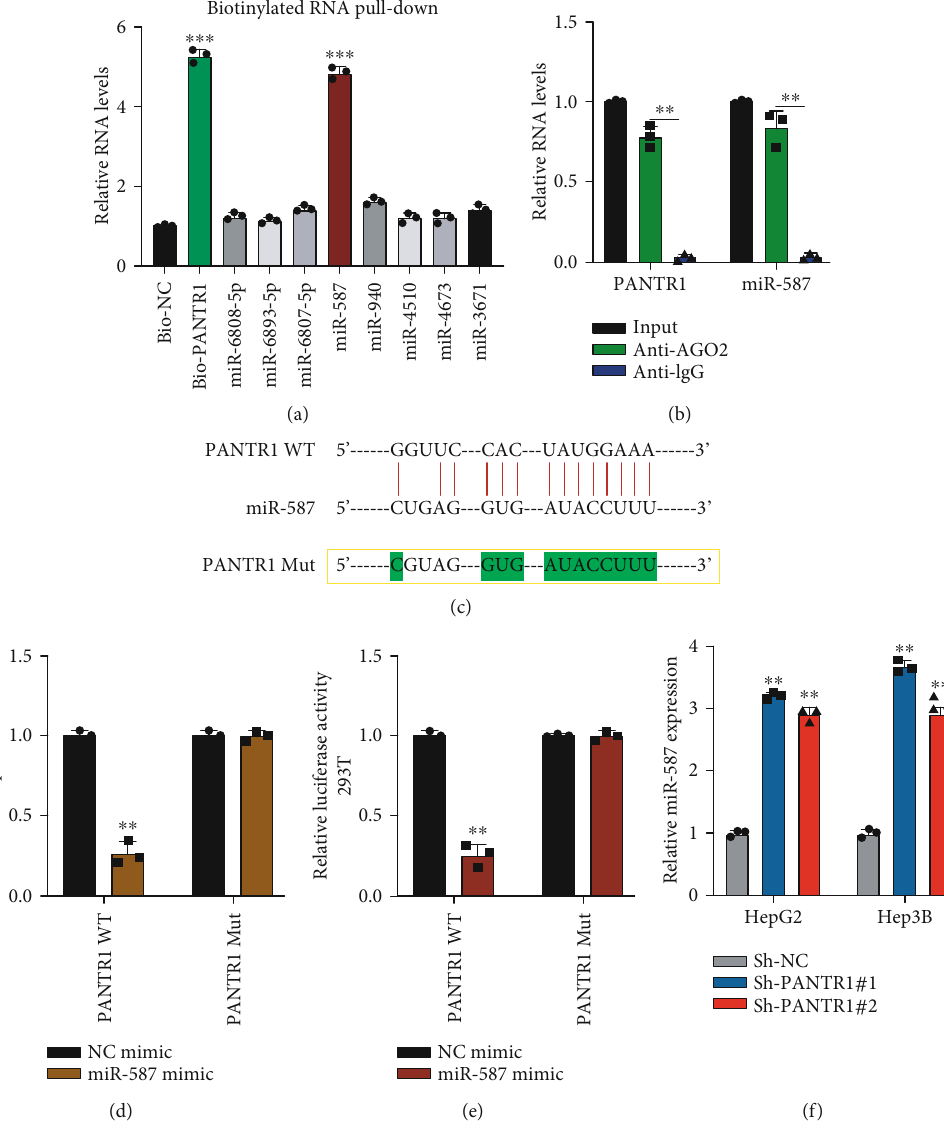
Figure 3: PANTR1 acts as a molecular sponge for miR-587. (a) Biotinylated RNA pull-down assays were conducted by using Bio-NC and Bio-PANTR1 probes. RNA complexes were analyzed by qRT-PCR. (b) AGO2-RIP using anti-AGO2 and anti-IgG antibodies were performed. RNA expressions were detected by qRT-PCR. (c) The binding sites between PANTR1 and miR-587 are shown. (d, e) Luciferase reporter experiments were performed by transfecting NC mimic, miR-587 mimic, reporter vectors harboring PANTR1 wild- type or mutant-type sequences into HepG2 or 293T cells, respectively, and results were statistically analyzed. (f) The miR-587 expression in Sh-NC or Sh-PANTR1-transfected HepG2 or Hep3B was detected by qRT-PCR. Data are shown as the mean ± standarddeviation ( n = 3 ). ∗ P < 0 : 05 , ∗∗ P < 0 : 01 , and ∗∗∗ P < 0 : 001